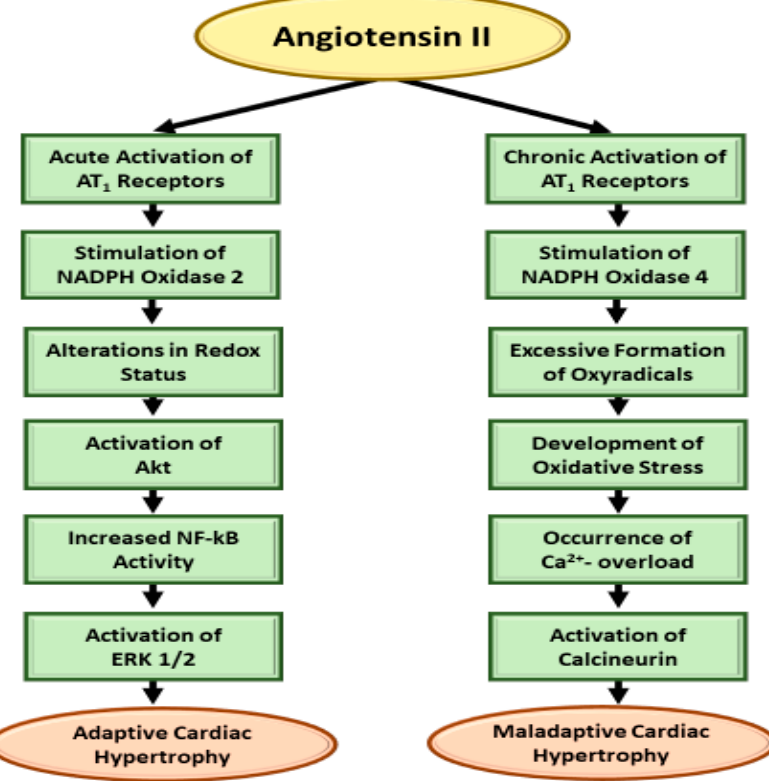
Figure 3. A schematic representation for the AT 1 receptors and redox status mediated signal transduction pathway as well as AT 1 receptor and oxidative stress-calcineurin pathway for the development of acute and chronic cardiac hypertrophy, respectively. Although different other signal transduction pathways such as ROS, PKC, ERK1/2, Akt, NF- κ B and NOX, p38 MAPK, c-JNK, NF- κ B have been identified to explain Ang II—induced pathological (maladaptive) cardiac hypertrophy, their involvement including that of Ca 2+ , calmodulin in the development of physiological (adaptive) cardiac hypertrophy is poorly understood.